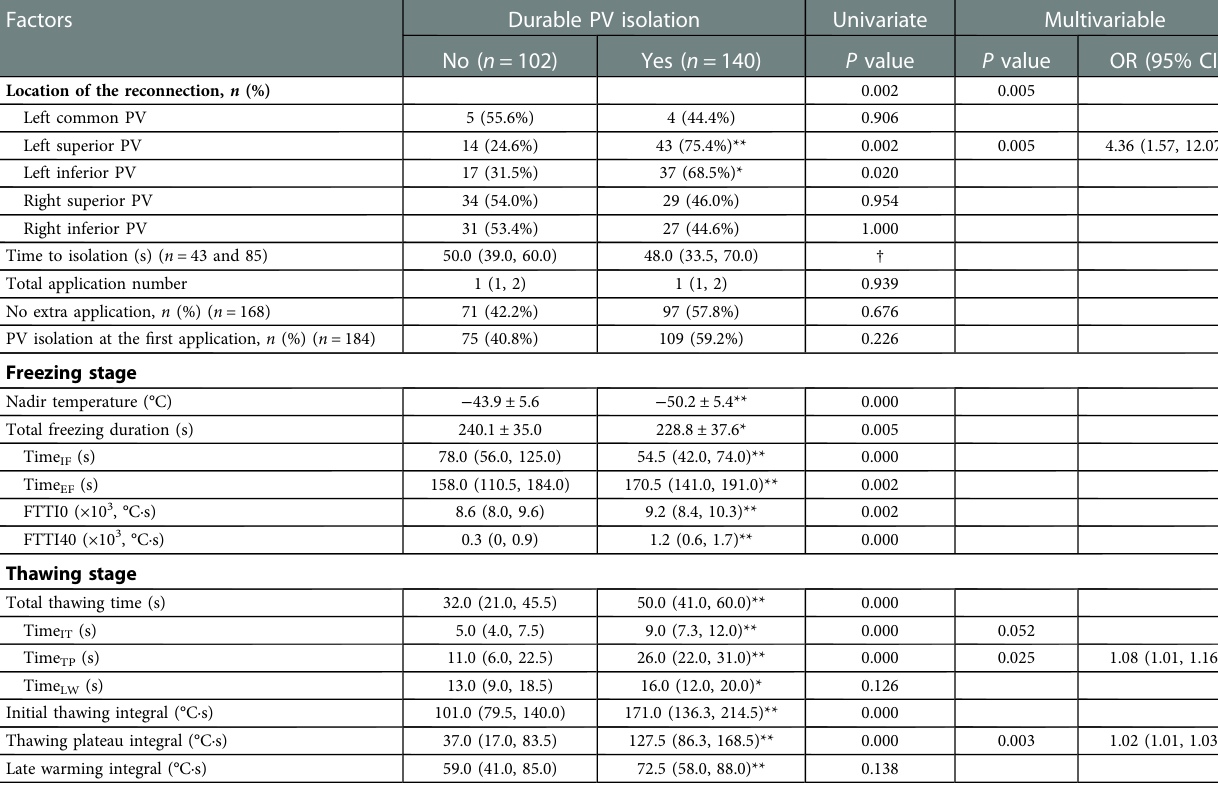
TABLE 2 Association between procedural parameters and durable PV isolation.